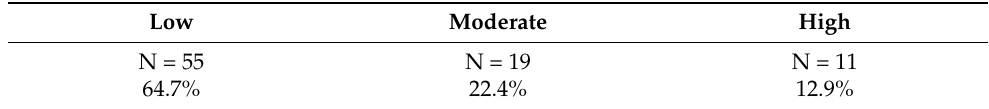
Table 3. Perception of self-influence on the disease course among patients with untreated MDD in the setting of kidney disease.